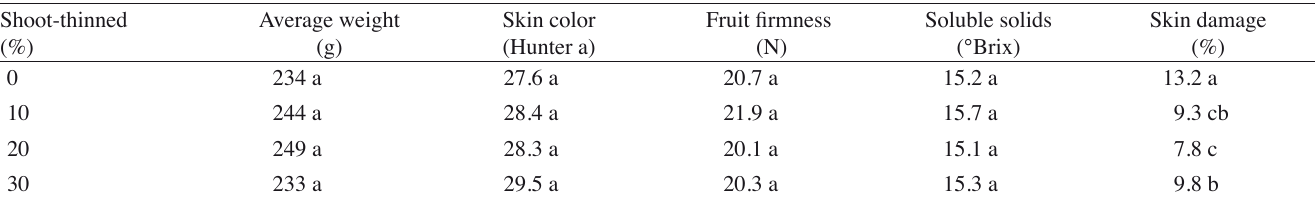
After summer pruning of seven-year-old trees, the leaf-fruit ratio was changed from 39 of 0% thinning to 28 of 30% thinning in an orchard planted at 6 x 3 m.